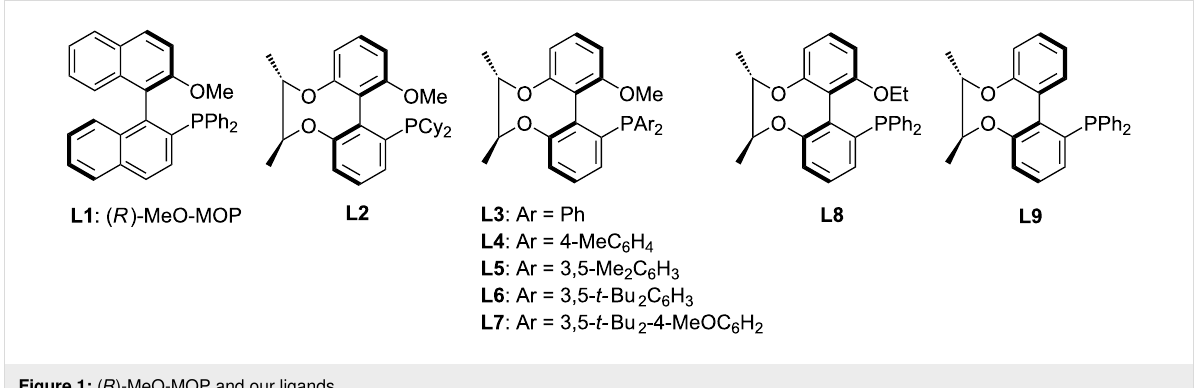
Figure 1: ( R )-MeO-MOP and our